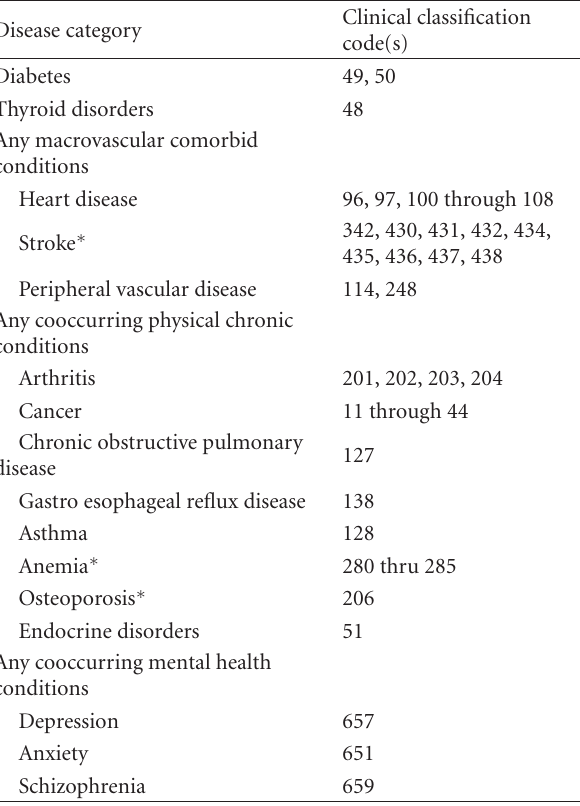
Table 5: CCS codes used to identify cooccurring and macrovascular comorbid conditions from the Medical Expenditure Panel Survey, 2007 and